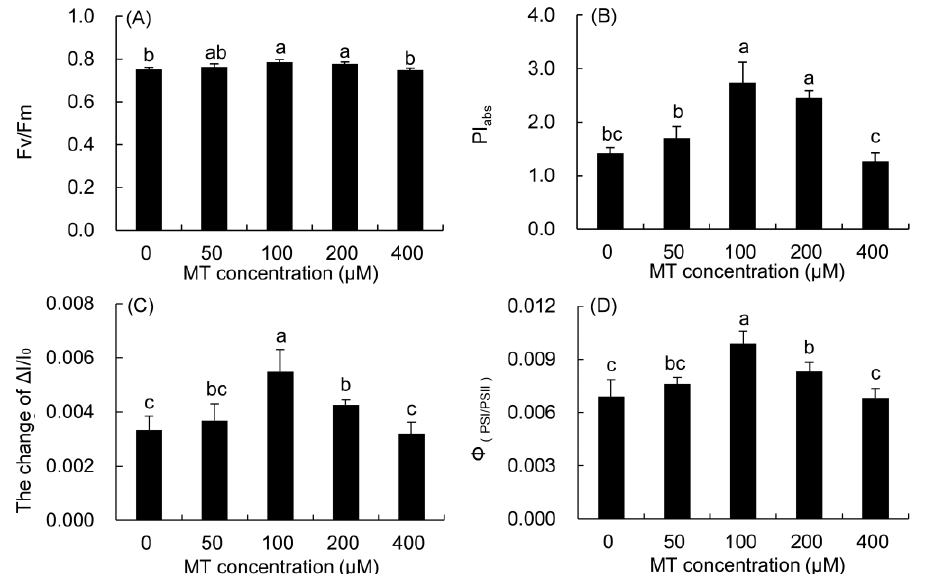
Figure 7. Effects of different concentrations of MT on the function and coordination of PSII and PSI of P. vulgaris. Fv/Fm, ( A ); PI abs , ( B ); ΔI/I 0 , ( C ) and Φ PSI/PSII , ( D ); MT: melatonin. Data are means ± standard error; different letters indicate significant differences as determined by the Duncan test ( p ≤ 0.05).